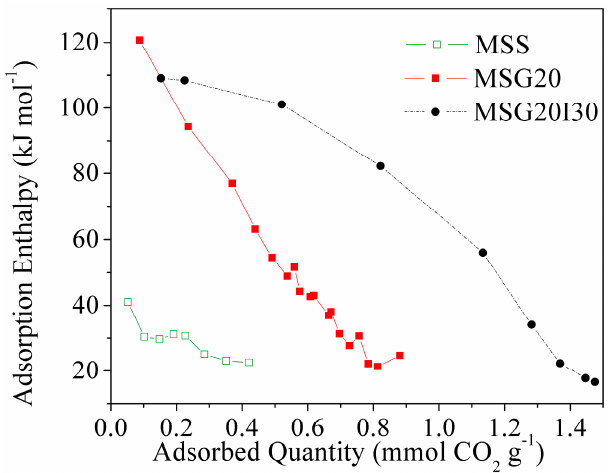
Figure 5. Differential enthalpy of adsorption in function of CO 2 uptake for mesoporous silica.